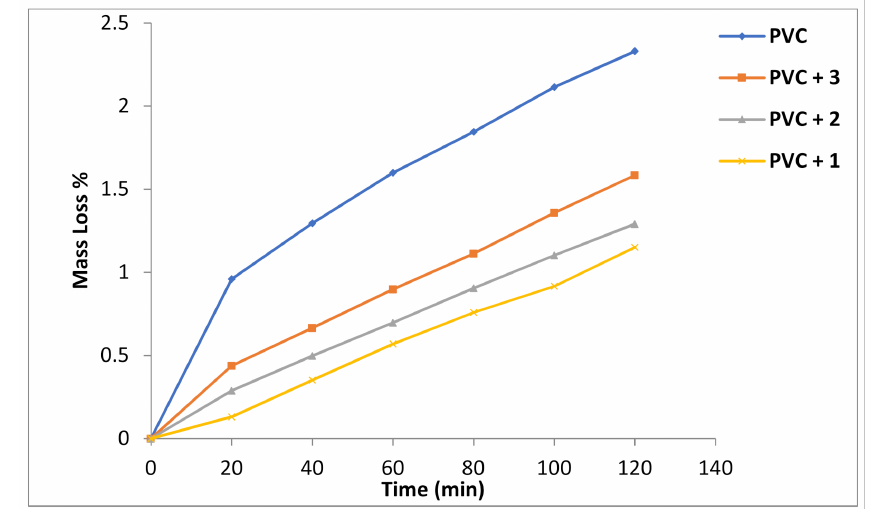
Figure 4. Changes in mass loss (%) upon thermal